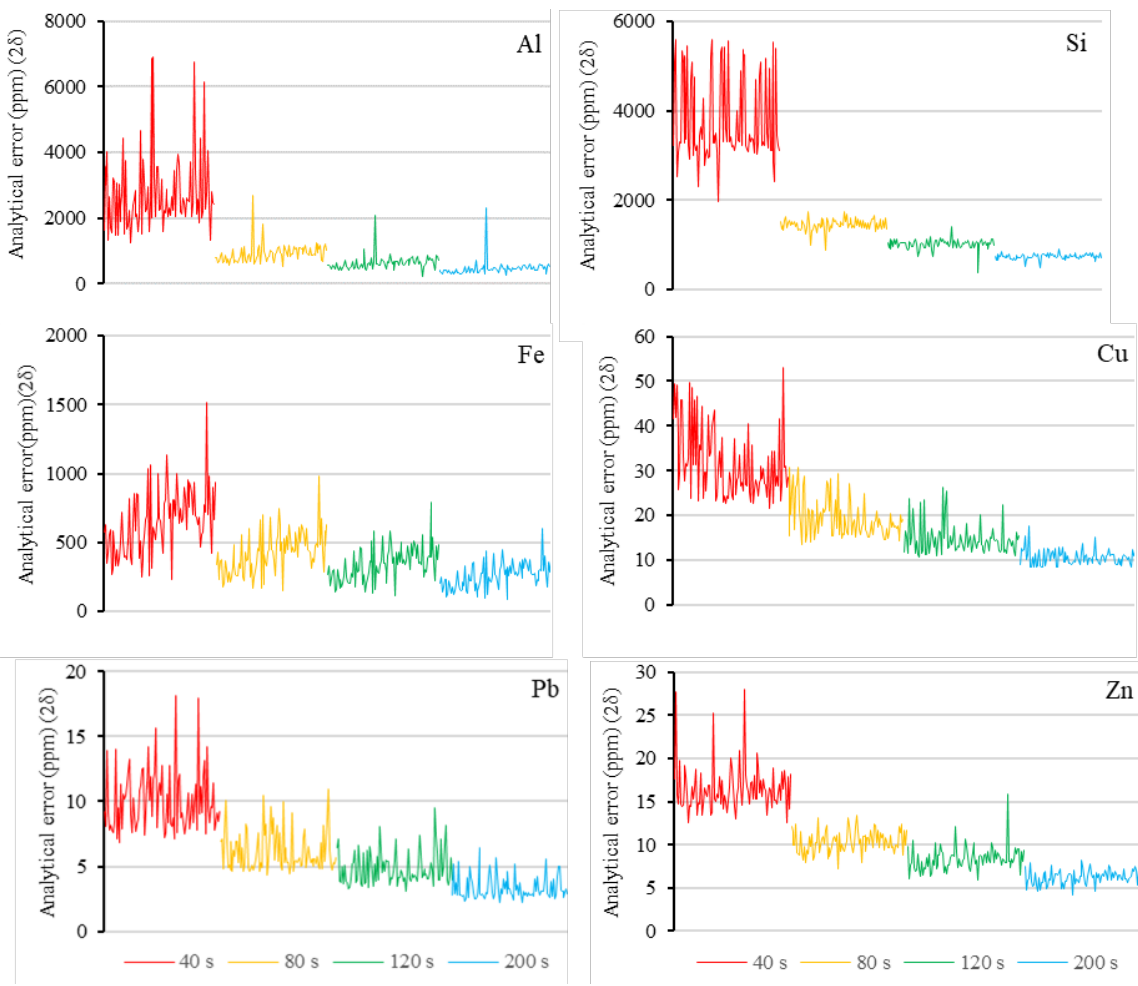
Figure 4. Analytical error of rock powder samples by pXRF based on different detection times.